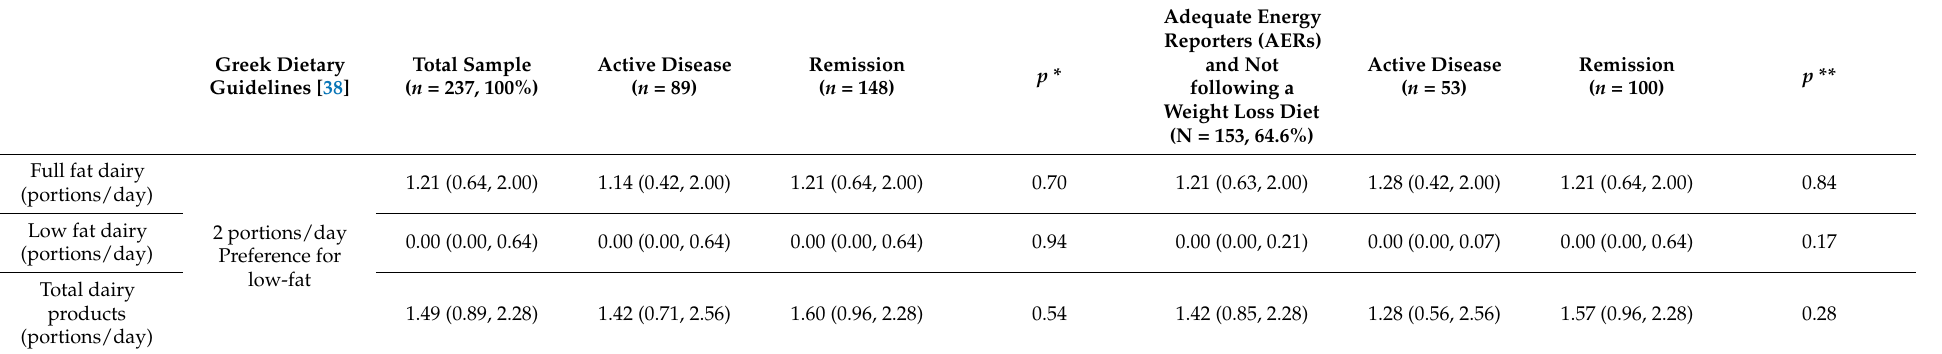
Table 3. Food groups consumption, MedDietScore and total score for adherence to healthy diet characteristics for the primary prevention of cardiovascular